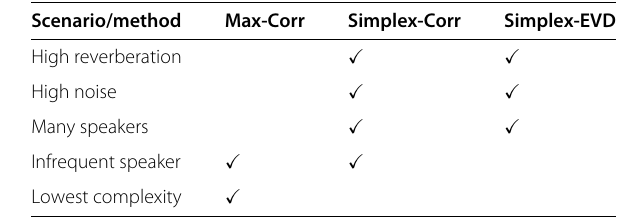
Table 5 Preferred methods in different